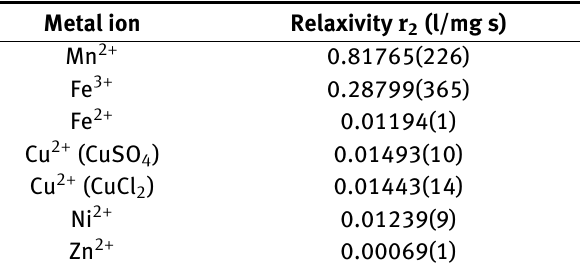
Table 2: Relaxivity r 2 results for metal ions obtained from a water- based solution by TD-NMR. Numbers in parentheses show the errors of the